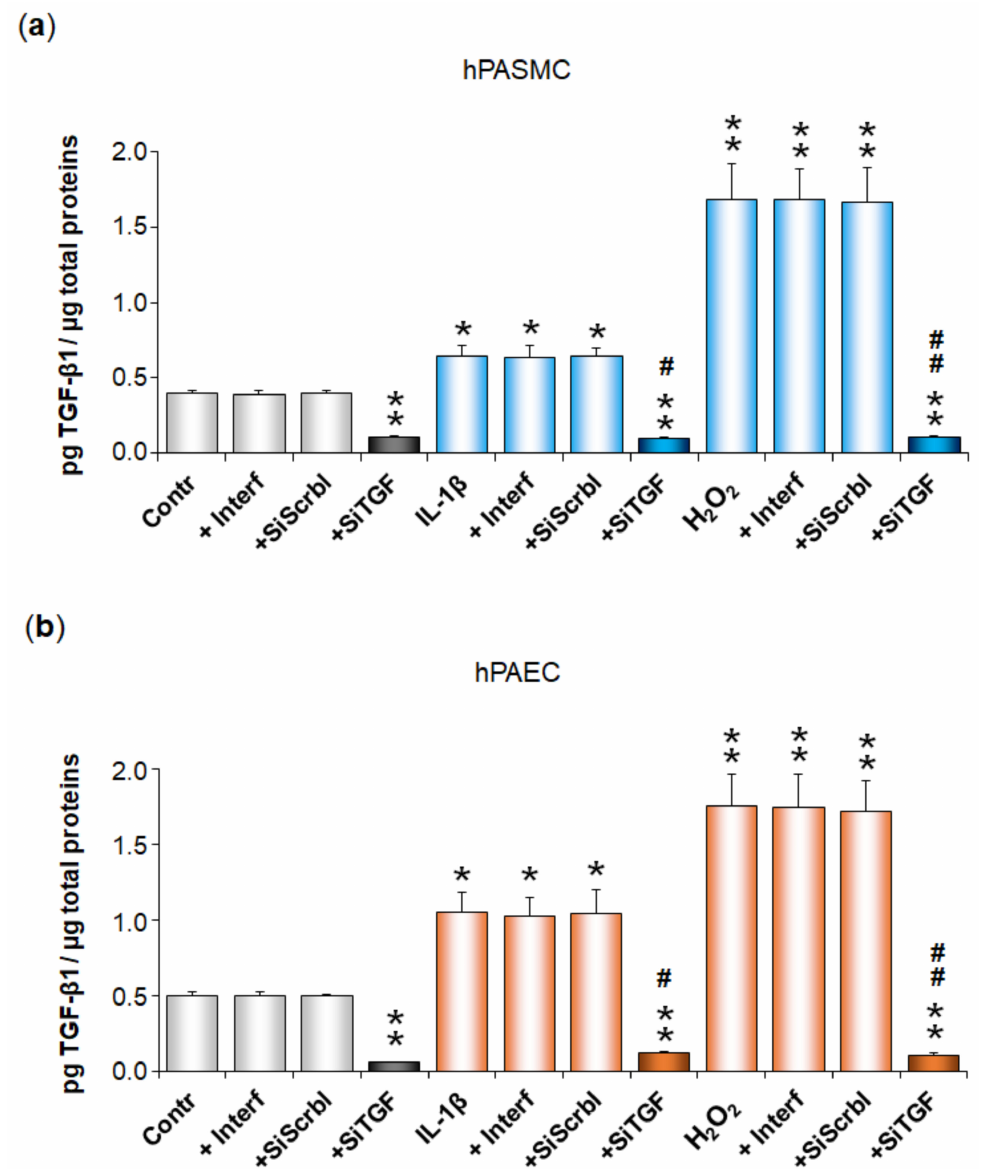
Figure 3. Control of TGF- β 1 decreased secretion after transfection of pulmonary arterial cells with an anti TGF- β 1 siRNA. TGF- β 1 secretion by human pulmonary arterial smooth muscle cells (hPASMC, ( a )) or human pulmonary arterial endothelial cells (hPAEC, ( b )) was assessed in the absence or presence of interleukin-1 β (IL-1 β , 10 ng/mL, 24 h) or hydrogen peroxide (H 2 O 2 , 10 µ M, 24 h).